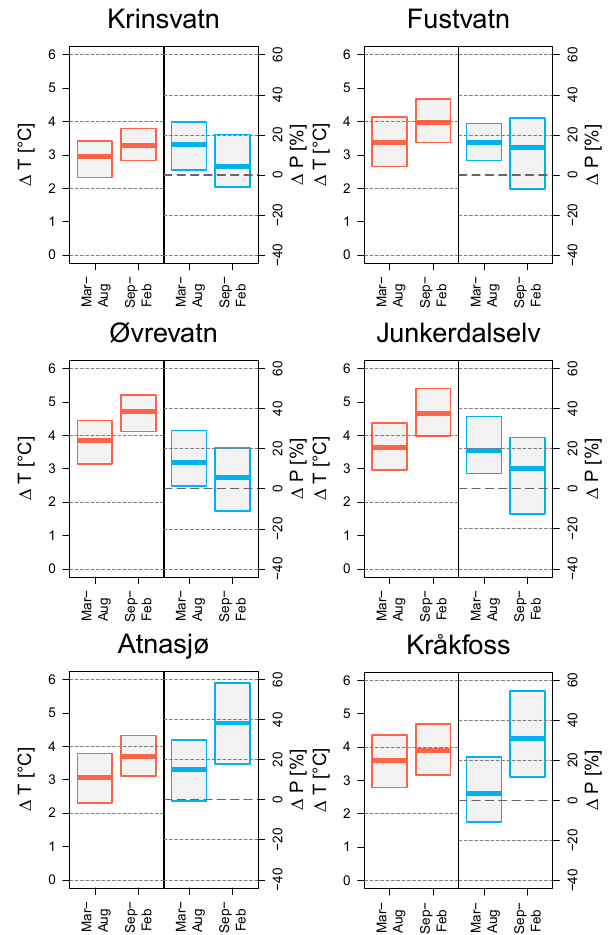
Figure 3. The interquartile ranges of the projected changes from the reference (1961–1990) to the future period (2071–2099) in mean temperature (left panel) and precipitation sums (right panel) for the spring/summer and autumn/winter seasons as they are locally ad- justed by EQM and XDS for the six study